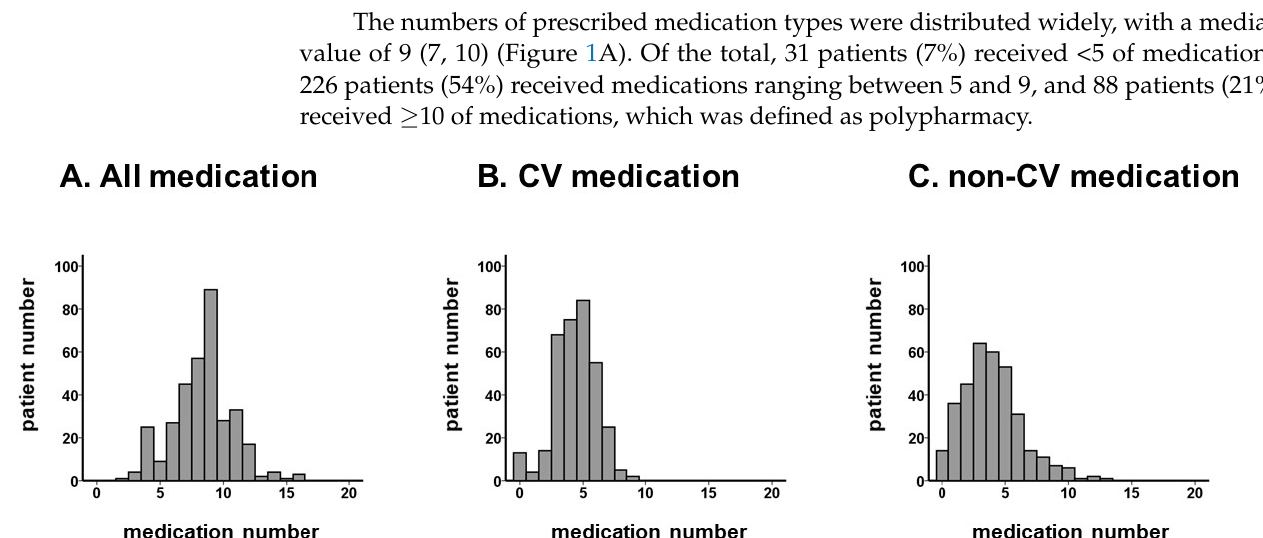
Figure 2. Distribution of median medication number in each age category: all medication ( A ), CV medication ( B ), and non-CV medication ( C ). The numbers of medications were not significantly stratified by age. The numbers of CV medications decreased as incremental age. The number of non- CV medications remained unchanged with incremental age. CV, cardiovascular. Median medication numbers were compared among each group using Wilcoxon signed-rank test. * p < 0.05. 3.3. Stratification of Patients’ Cohort by Polypharmacy Patients were divided into two groups by the presence of polypharmacy (N = 88) (Table 1). There were no significant differences in demographic data, including age. The prevalence of major comorbidities was not significantly different between the two groups, except for the higher prevalence of coronary artery disease in patients with polypharmacy (36% versus 22%, p = 0.006). Patients with polypharmacy had lower serum albumin, worse renal function, lower cholesterol levels, and higher levels of plasma B -type natriuretic pep- tide levels compared with others ( p < 0.05 for all). Frailty index, including mini-mental state examination and CSHA score, were not significantly different between those with and without polypharmacy. The number of potentially inappropriate medications tended to be higher in patients with polypharmacy compared with those without polypharmacy [3 (1, 4) versus 2 (1, 3); p = 0.087]. 3.4. Impact of Polypharmacy on Clinical Outcomes During the observational period (median 730 [356, 730] days), 21 patients died (4 from cardiovascular causes and 17 from non-cardiovascular causes; Table 2). The medica- tion number was associated with 2-year mortality in unadjusted and adjusted models